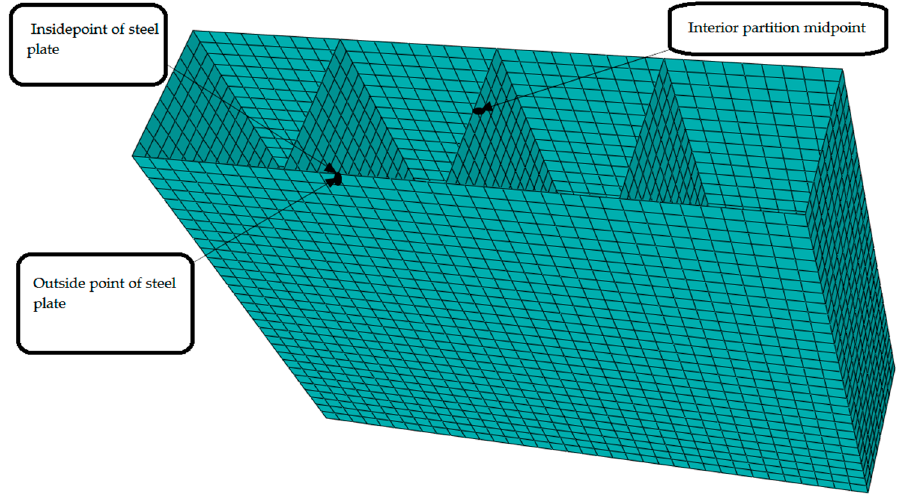
Figure 18. Position of each characteristic point (H/2) of multi-cavity steel tube section.